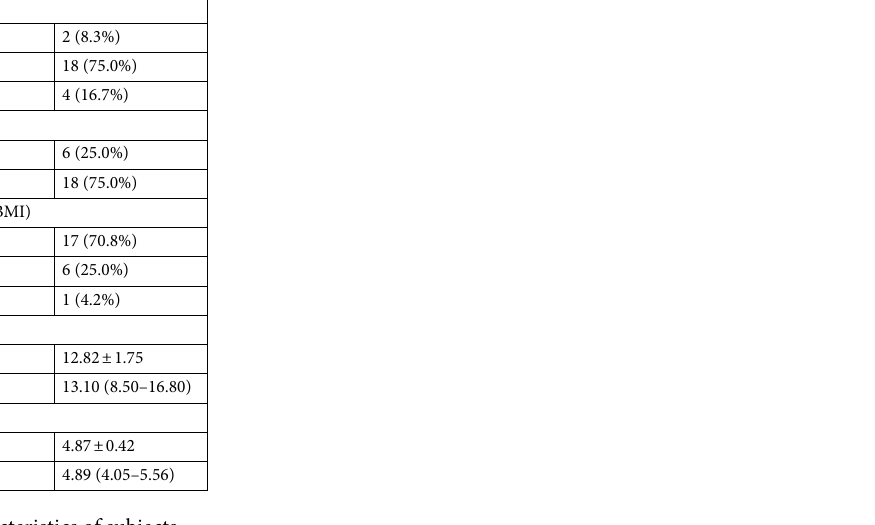
Table 1. Characteristics of subjects.